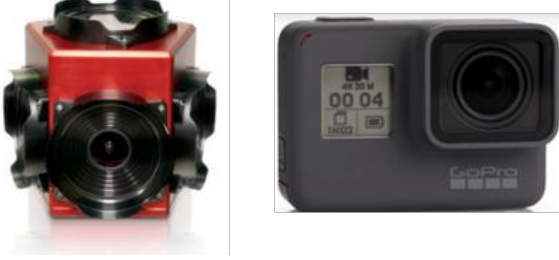
Figure 1. Left: Ladybug5(“Ladybug5 360 Degree USB3 Spherical Camera Systems,” 2019). Right: GoPro Hero5(“HERO5 Black Quick Start - Overview,” 2019, p.